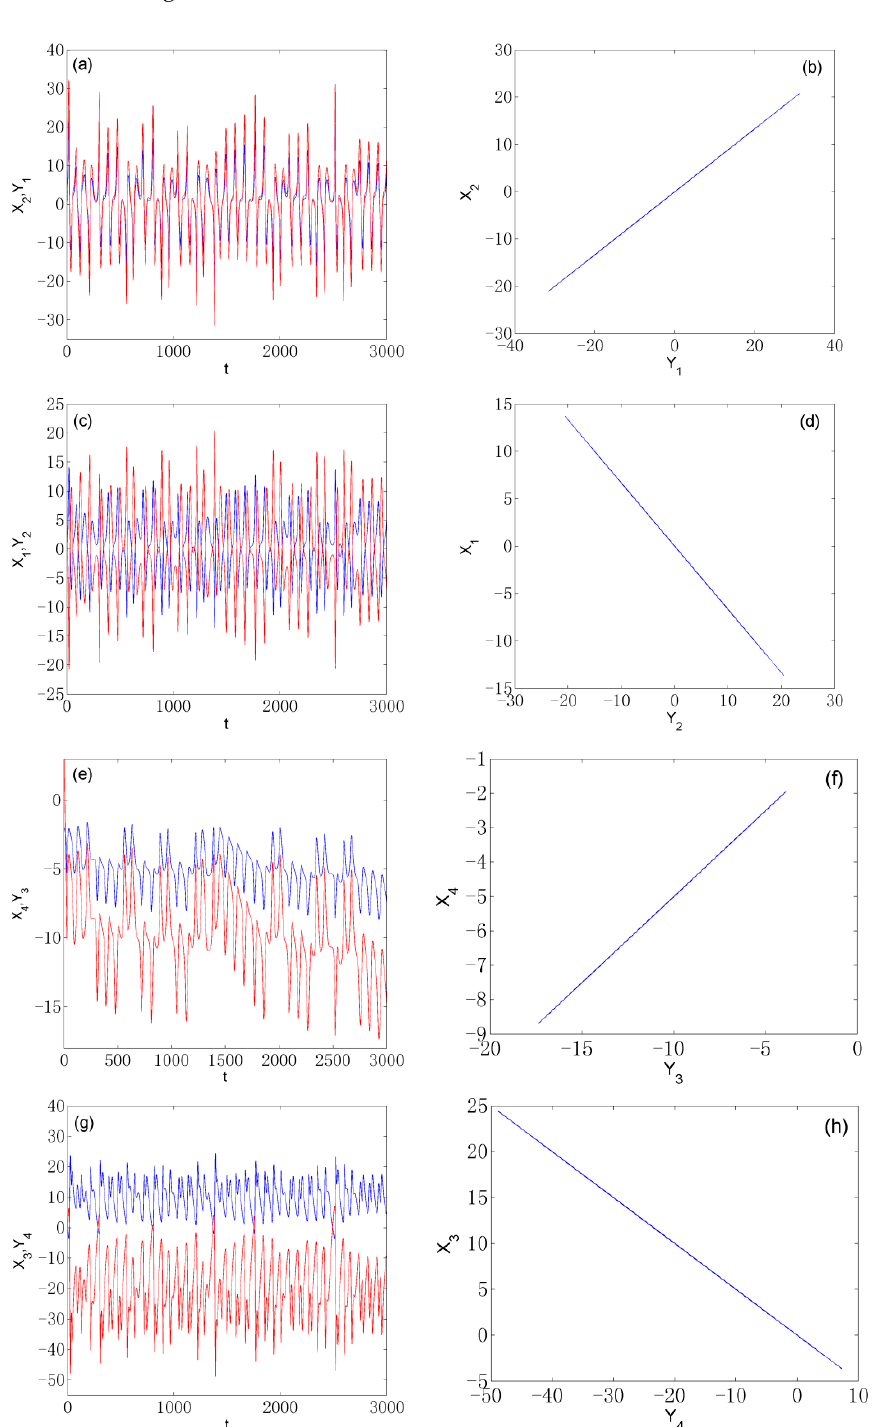
Figure 6. Evolution of error curves of system (15). (a)The blue line means Error 1; (b)The green line denotes Error 2; (c)The pink line is Error 3; (d)The yellow line is Error 4. Case 2. Generalized linear synchronization. Obviously, the 4 ‐ dimensional matrix  selected in the generalized dislocation synchronization is a special matrix, so the generalized dislocation synchronization is only a special case. When the 4 ‐ dimensional matrix  is a real matrix, it is a common case of this scheme, namely, generalized linear synchronization. Therefore, we take the following real matrix  as an example.